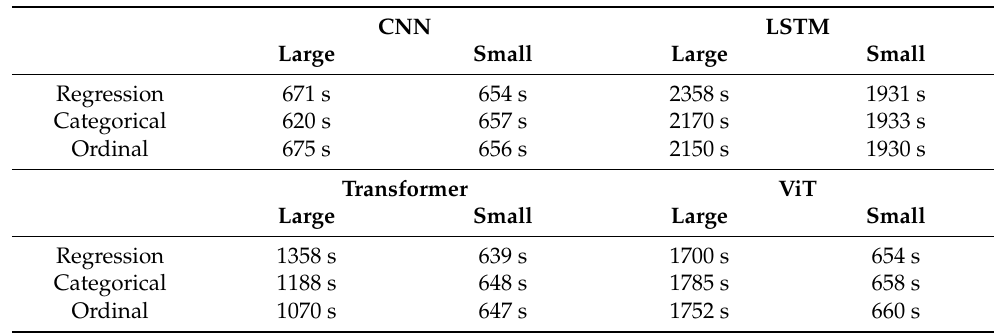
Table 4. Neural network mean training times per